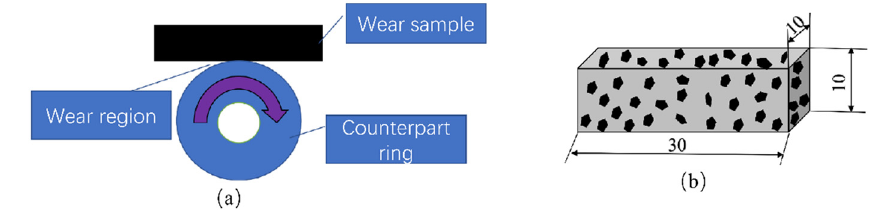
Figure 5: ( a ) Schematic diagram of a dry sliding wear test bench. ( b ) Standard sample.